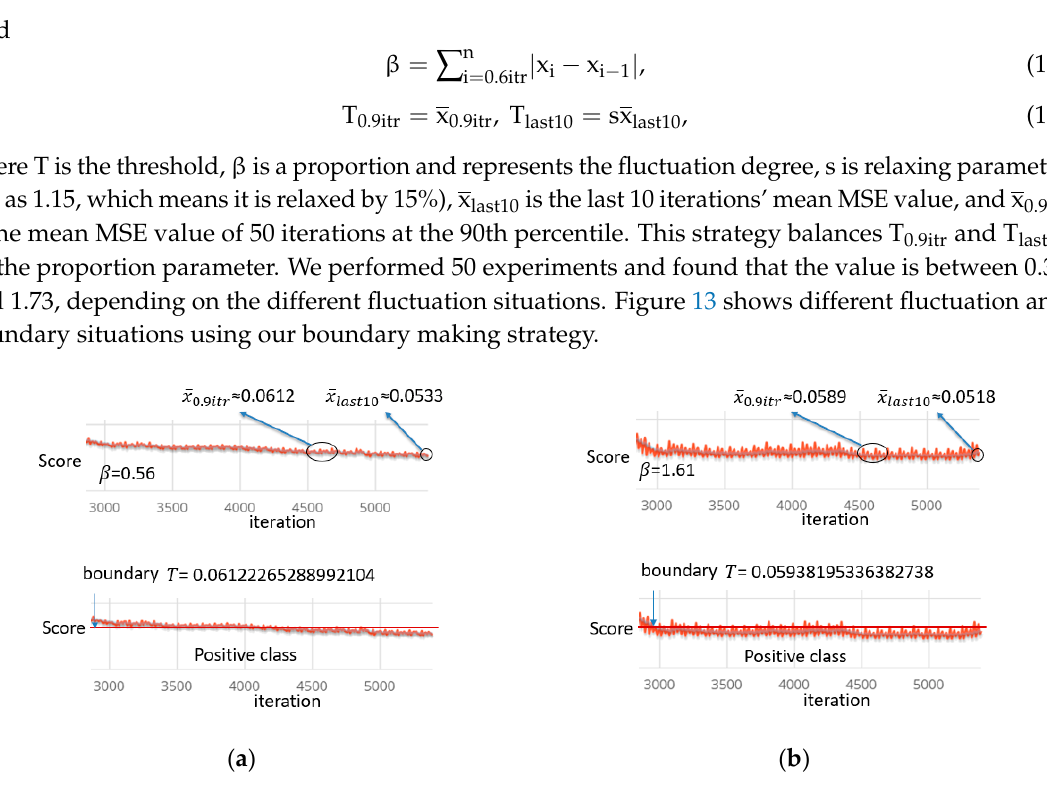
Figure 13. Example fluctuation and boundary situations. The curve is the intercepted segment of last part of training. ( a ) Is a relative stable situation while ( b ) is relatively unstable. T is the boundary shown by a red line.